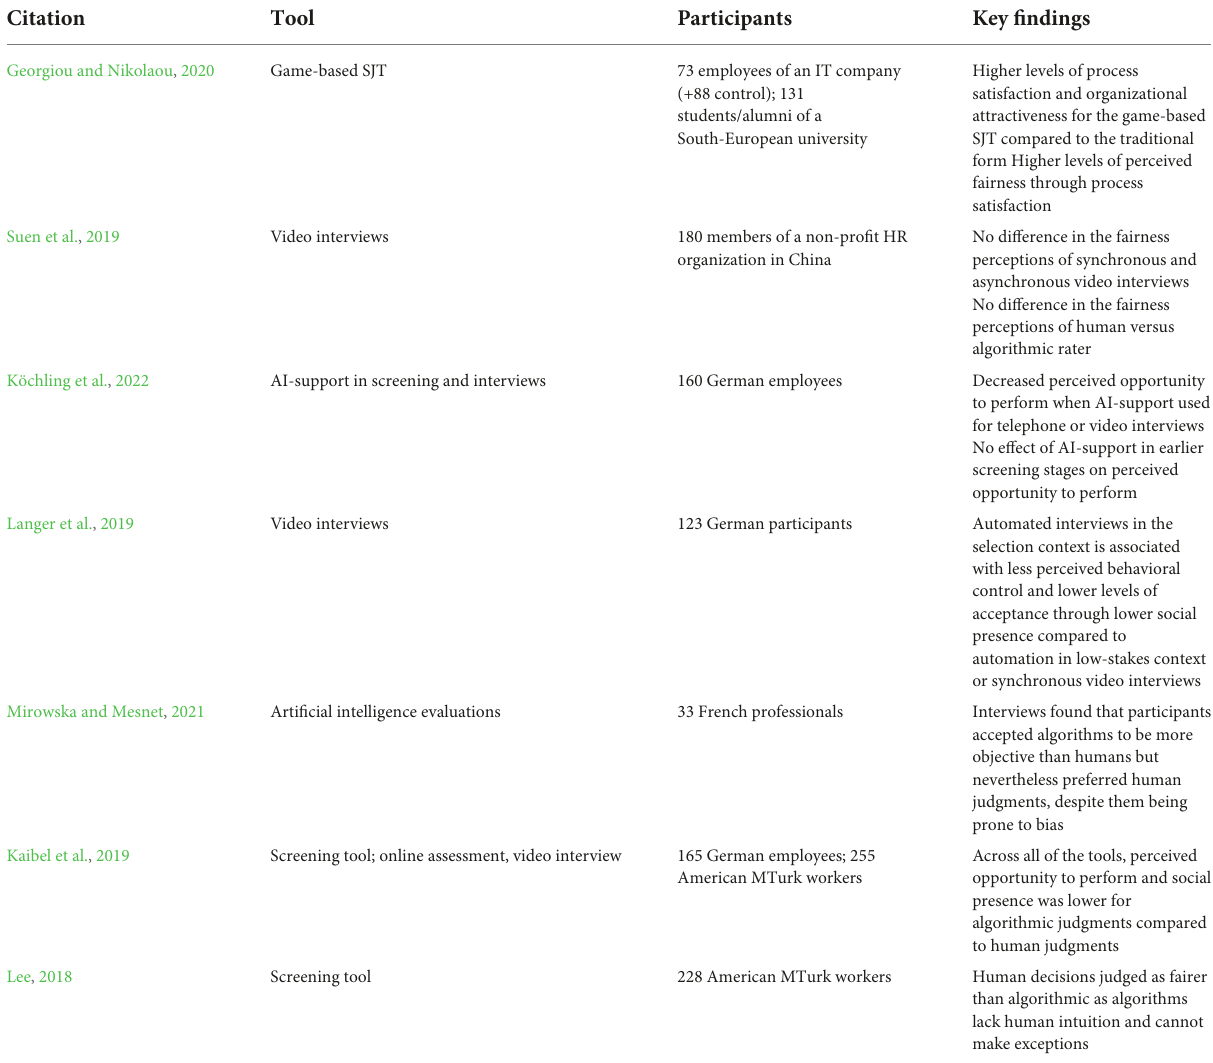
TABLE 1 A summary of the key findings of the seven key studies